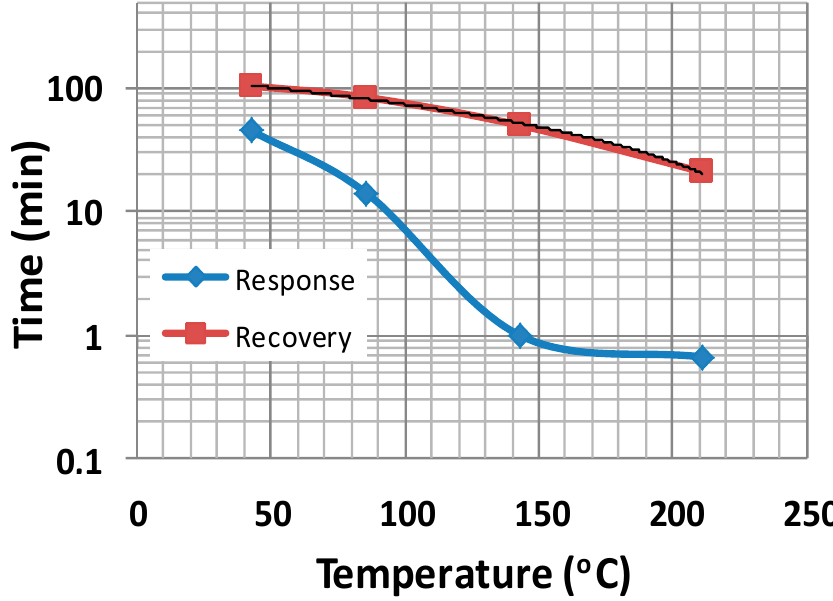
Figure 8. Response and recovery times vs. temperature for the sample shown in Figure